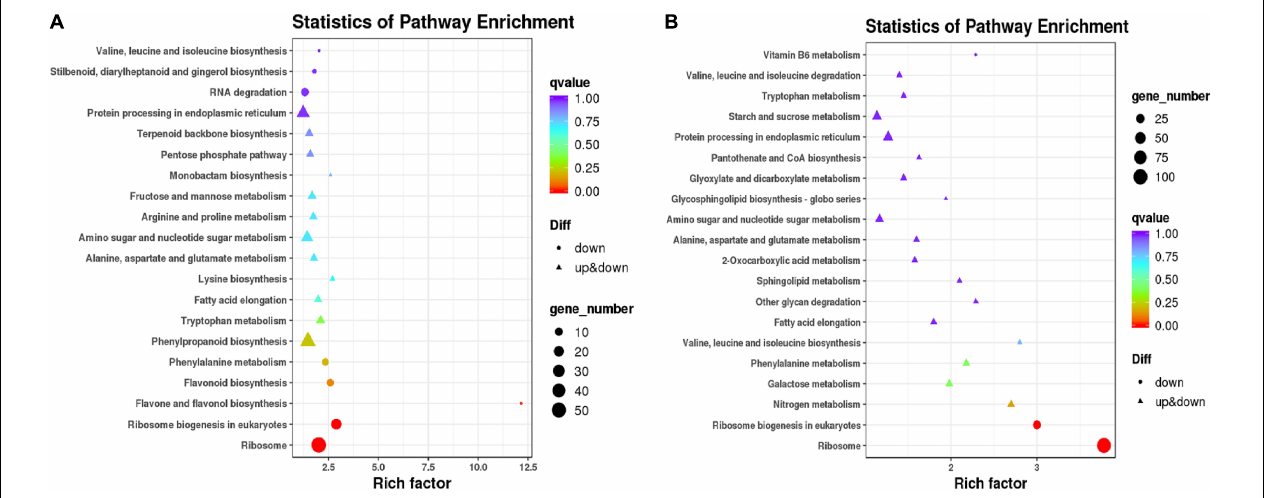
FIGURE 2 | Venn diagram and KEGG analysis of differentially expressed genes in resistant/sensitive millet. Venn diagram of DEGs between two samples: (A) GCK and GT; (B) LCK and